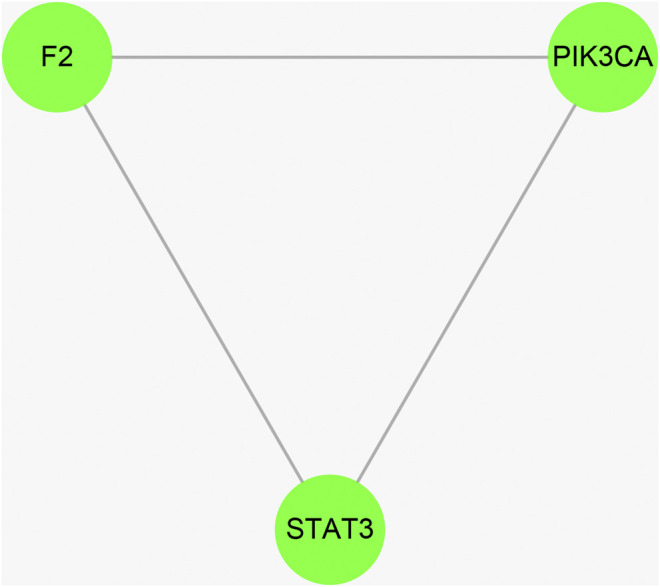
The hub targets of vitamin C with therapeutic potential for CVD were identified using the Cytoscape software. The median and maximum degrees of freedom of the target were 1 and 21, respectively. To screen the hub targets, the degree of freedom was set to >12.